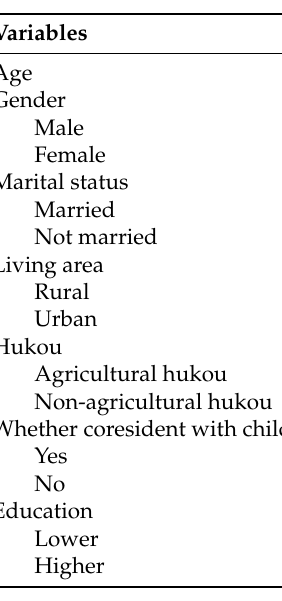
Table 1. Sociodemographic characteristics (N =